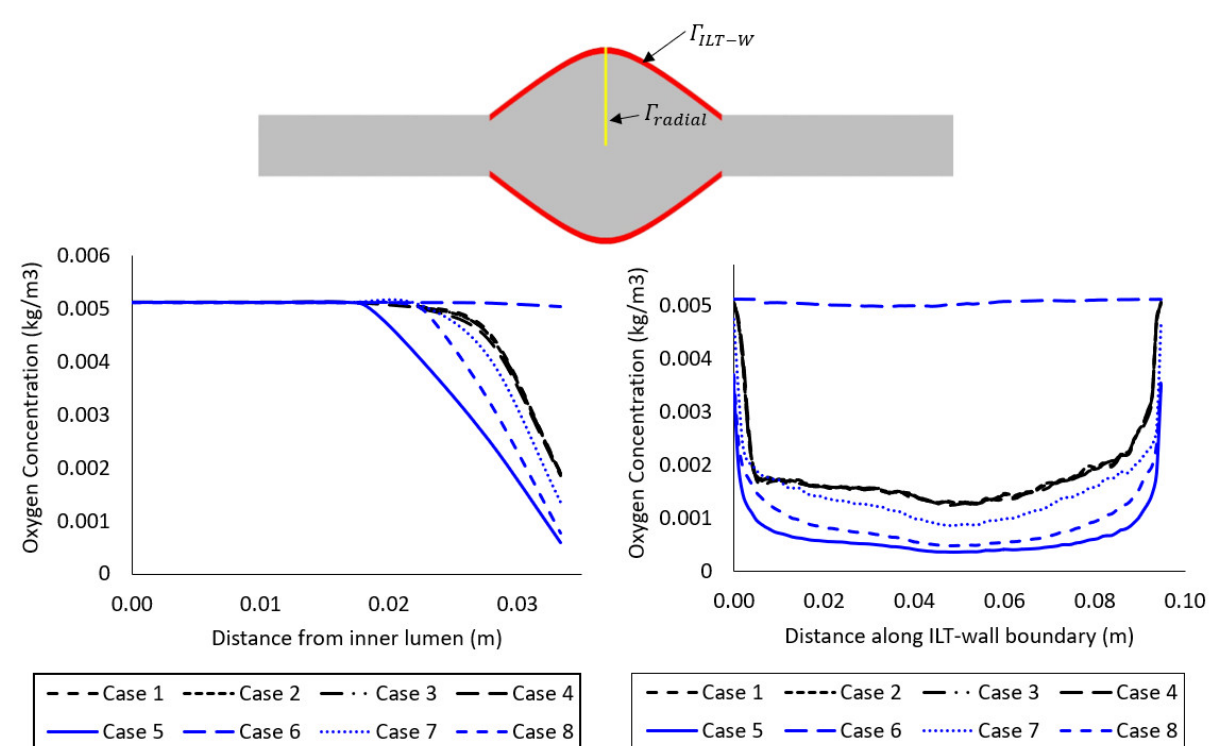
Figure 3. Comparison of the oxygen concentration along a radial path line at halfway along the length of the lumen in the cases with varying ILT oxygen diffusivity ( D ilt ) (Case 1–4) and ILT permeability ( K ilt ) (Case 5–8) on the left, and comparison of the oxygen concentration along the axial length on the interior interface of the arterial wall in the same cases (right). Case information for both plots is provided in Table 2. At the top, the path lines are shown with a yellow line, Γ radial for the left plot, and a red line Γ ILT − W for the right plot. The Γ ILT − W represents the interface between the ILT and wall domain. The same eight cases are shown in Figure 2.